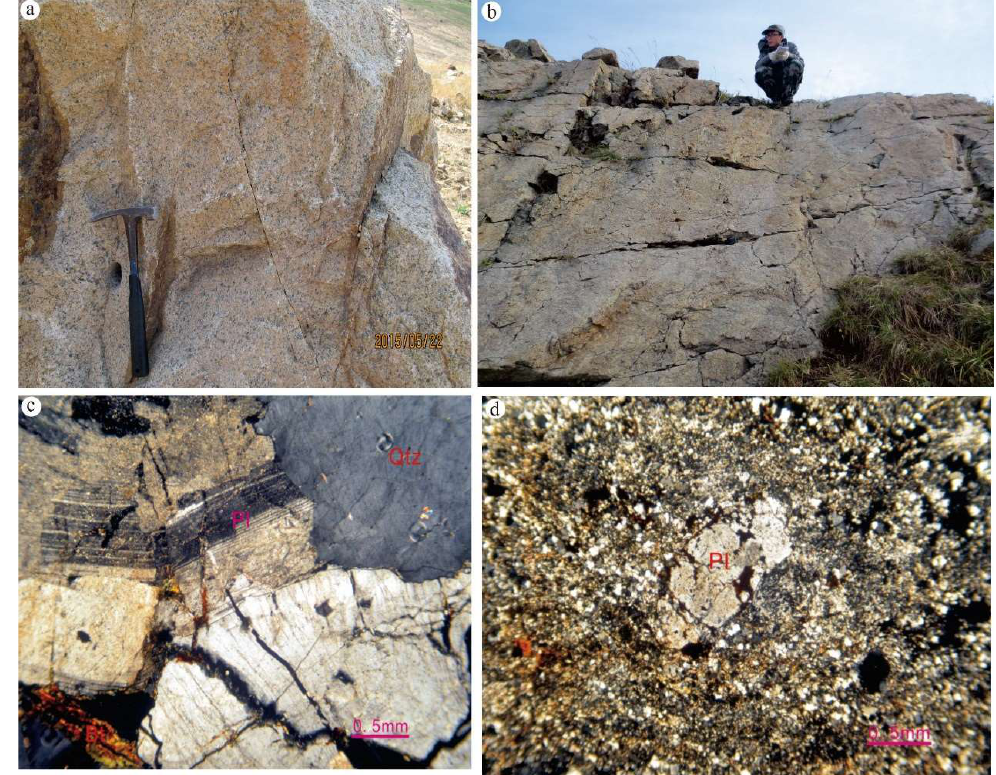
Figure 2. Field and microstructural photos of the Early Cretaceous magmatic rock in the Badaguan area: ( a ) granite outcrop; ( b ) rhyolite outcrop; ( c ) microscopic characteristics of the granite; ( d ) microscopic characteristics of the granite–rhyolite. Pl—plagioclase; Qtz—quartz; Bt—biotite.